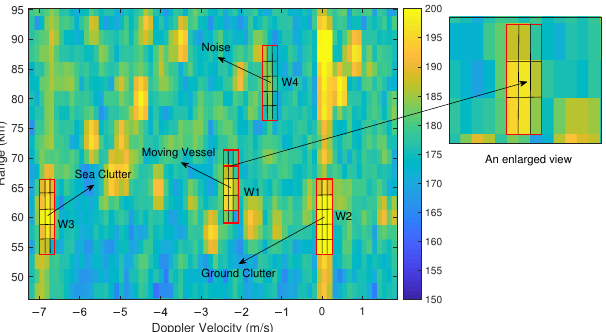
Figure 3. Reference window size determination for calculating local